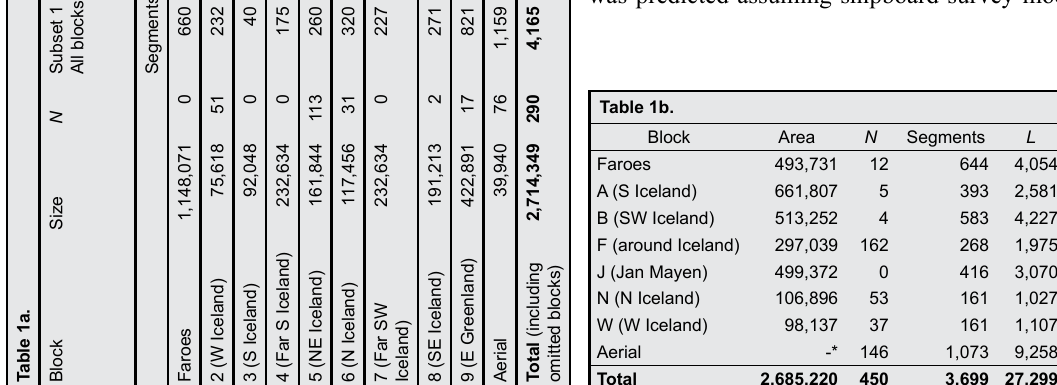
(and additionally, time for temperature). Maps of depths and temperatures over the 2 survey periods are shown in Fig. 3. Generalised cross validation (GCV) implemented in the mgcv package (v. 1.1 7, Wood 2001) in R (v. 1.9.1) was used for covari- ate selection, augmented with diagnostic plots, us- ing the principles described in Wood (2001) with the additional criterion that a term must explain an additional 4% of the deviance given other vari- ables in the model. All covariates were considered for inclusion in the model as 1D smooths of un- transformed covariate values and also as the loga- rithm of the covariate. In addition, 2D smooths of Lat and Lon and SST and Depth were considered for inclusion into the GAM. Initially a maximum of 6 degrees of freedom (7 knots) were allowed in the selection of 1D smooths and up to 13 degrees of freedom (14 knots) were allowed in the case of 2D smooths, thus allowing moderate flexibil - ity but reducing the likelihood of spurious over- fitting (fitting unnecessarily complicated func - tions) especially as GCV has been shown to cause overfitting (Mackenzie and Walker, submitted). Survey mode ( Mode ) was included in all models. Due to gaps in search effort along transects, ef- fort could not always be split into segments of the desired length (see later). Therefore, the size of each segment varied and so the model was weighted by segment area. The final model was used to predict density of humpback whales throughout the survey regions. Whale abundance was estimated by numerically integrating under this predicted whale density surface. As survey mode was included in each model, abundance was predicted assuming shipboard survey mode.